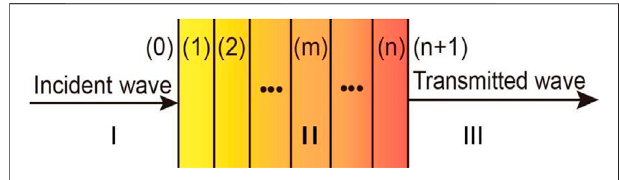
FIGURE 2 | Schematic diagram of